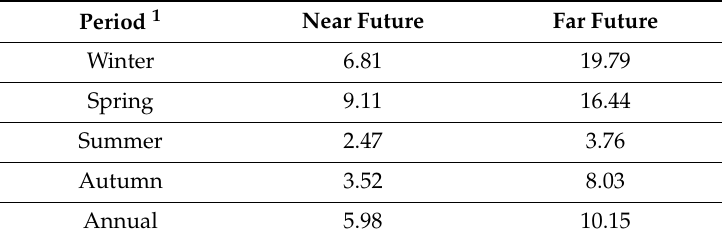
Table 4. Projection of precipitation increase (%) for near future (2021 to 2050) and far future (2071 to 2100) compared to the historical period (1971 to